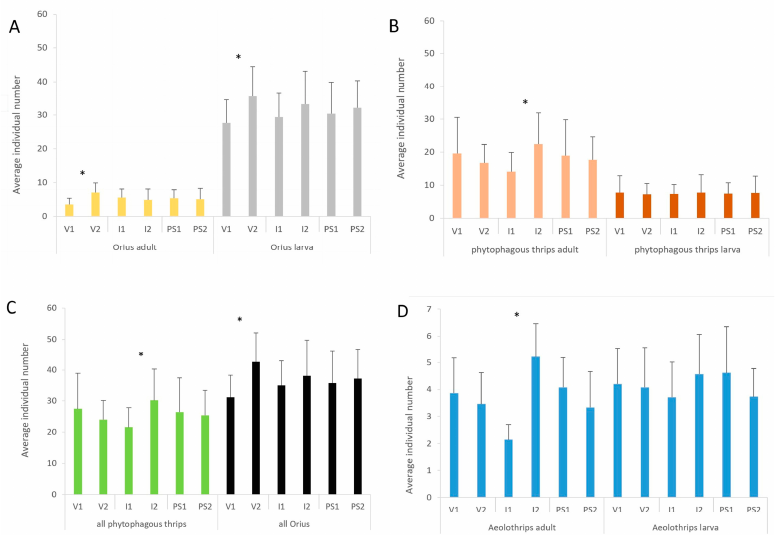
Figure 2. Average individual numbers of predatory and phytophagous insects in chili flowers under treatments in 2019: ( A ) Orius spp. ( B ) Phytophagous thrips. ( C ) All Orius and phytophagous thrips (adults and larvae). ( D ) Aeolothrips spp. (V1) Trinidad Scorpion Butch T; (V2) Yellow Scotch Bonnet; (I1) Irrigation daily, 40 min; (I2) Irrigation every second day, 20 min; (PS1) Increased plant spacing; (PS2) Decreased plant spacing. * Denotes significant differences between the treatment levels ( p < 0.001). The error bars represent the standard errors.